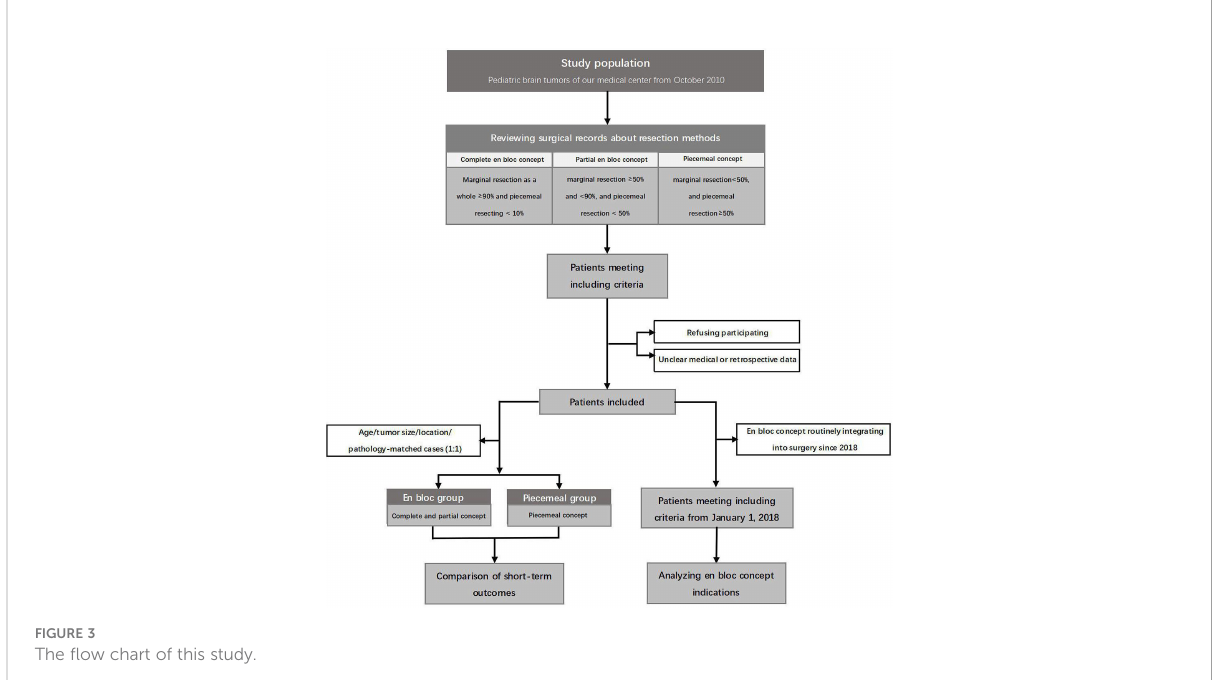
FIGURE 3 The fl ow chart of this